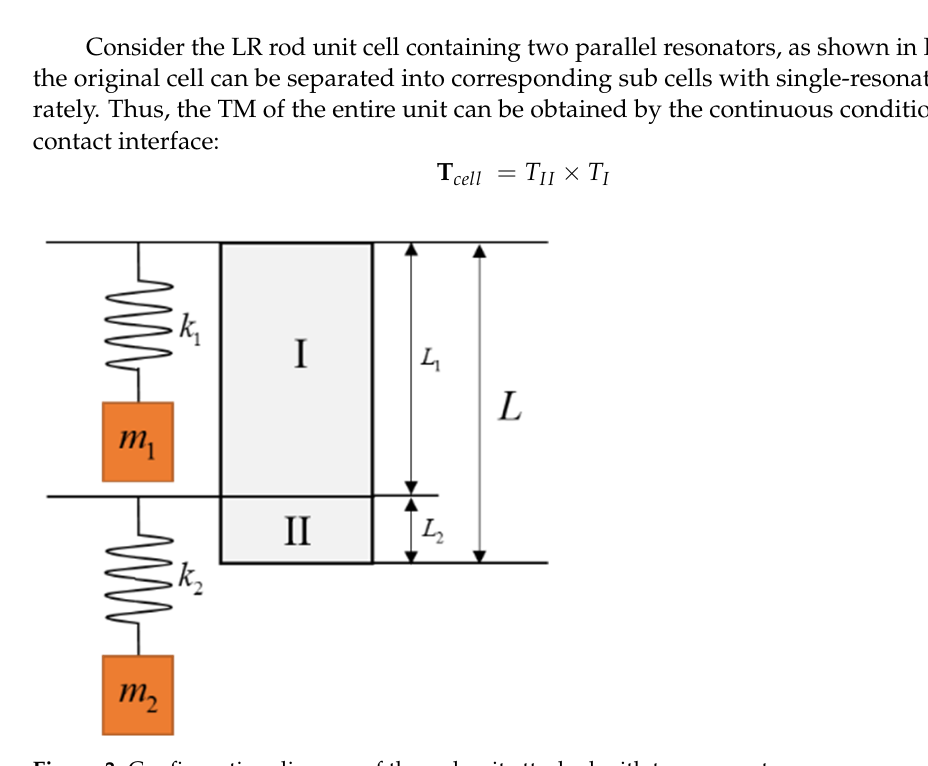
Figure 3. Configuration diagram of the rod unit attached with two resonators.